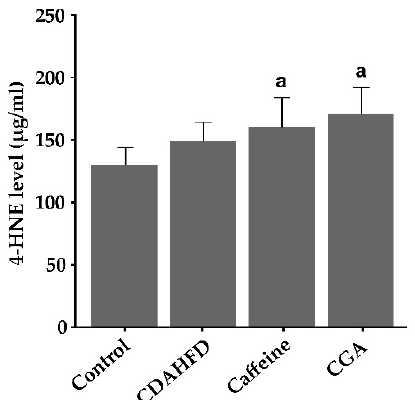
Figure 3. 4-Hydroxynonenal (4-HNE) levels in the liver. Levels are significantly higher in the caffeine and CGA groups than in the control group but are not significantly different from those in the CDAHFD group. a Significantly different from the control group ( p < 0.05).